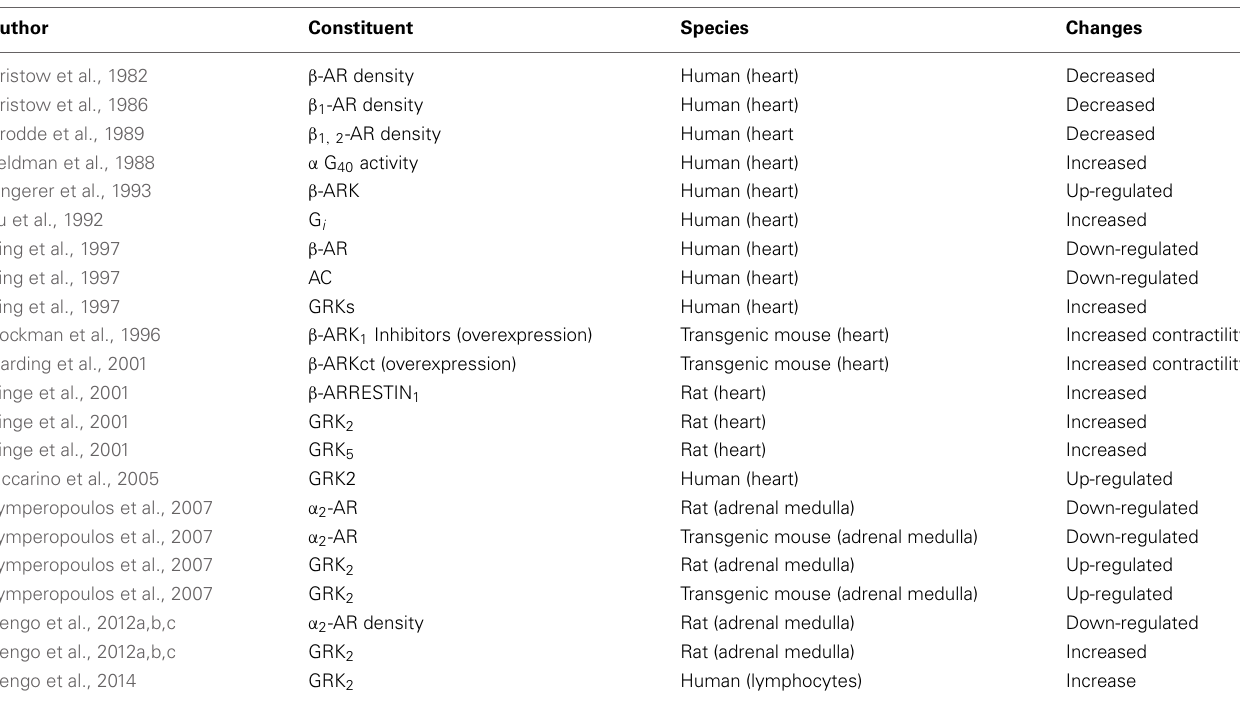
Table 2 | Failing heart: the main general changes in β -adrenergic